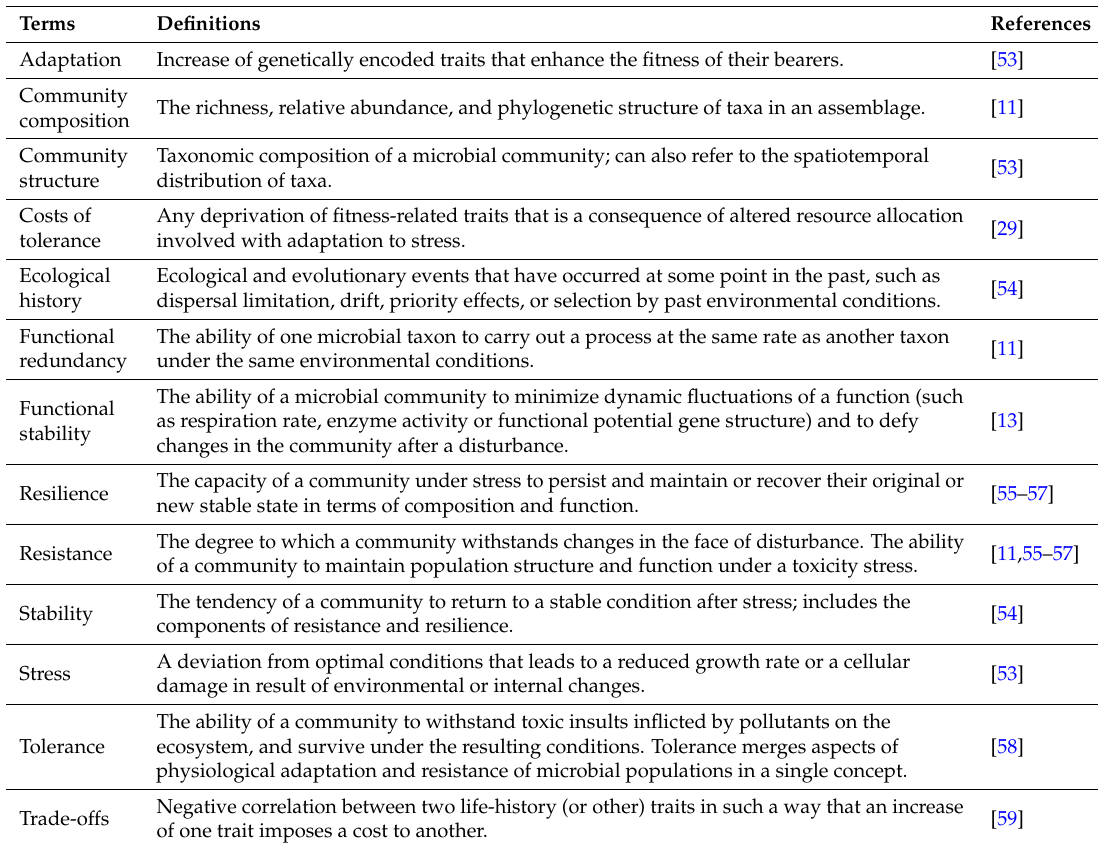
Table 1. Summary of definitions used in this